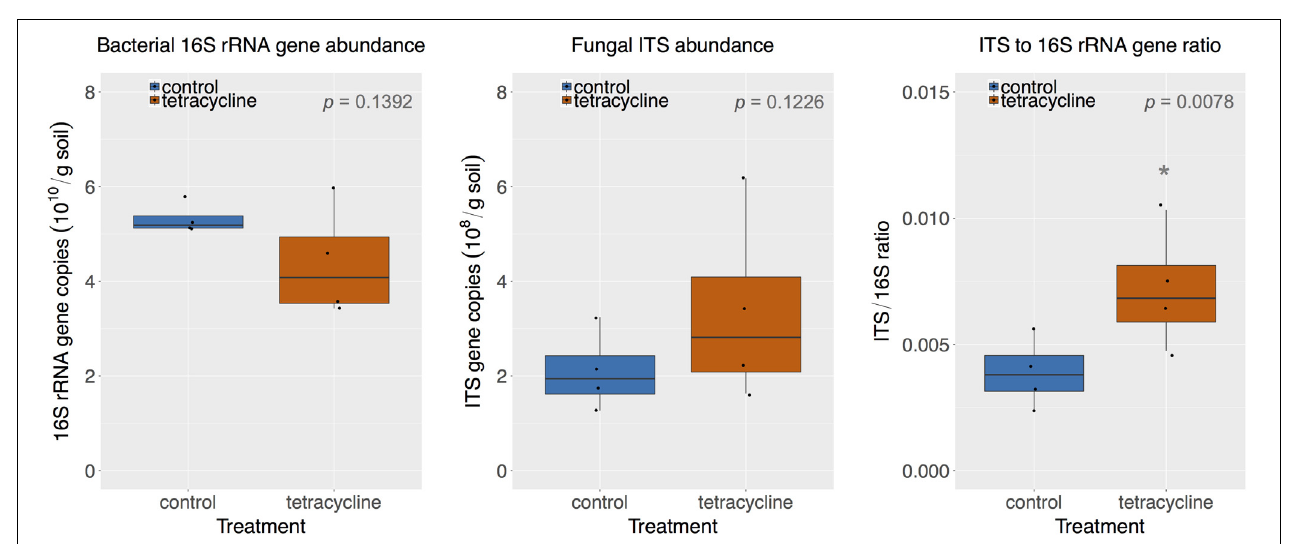
FIGURE 1 | N 2 O and N 2 production rates of control (blue) and tetracycline (red) samples. Significant difference between control and tetracycline treatment is marked with ∗ (paired Mann–Whitney-Wilcoxon test, p < 0.05). Each sample is represented by one point. The boxes represent the first and third quartiles, with median value bisecting each box. The whiskers extend to the largest/smallest value, excluding outliers (data beyond 1.5 × inter-quartile range).